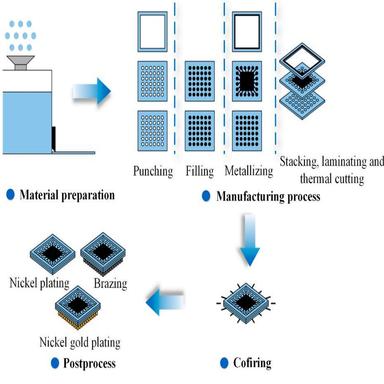
Conventional preparation process of co-fired ceramics.